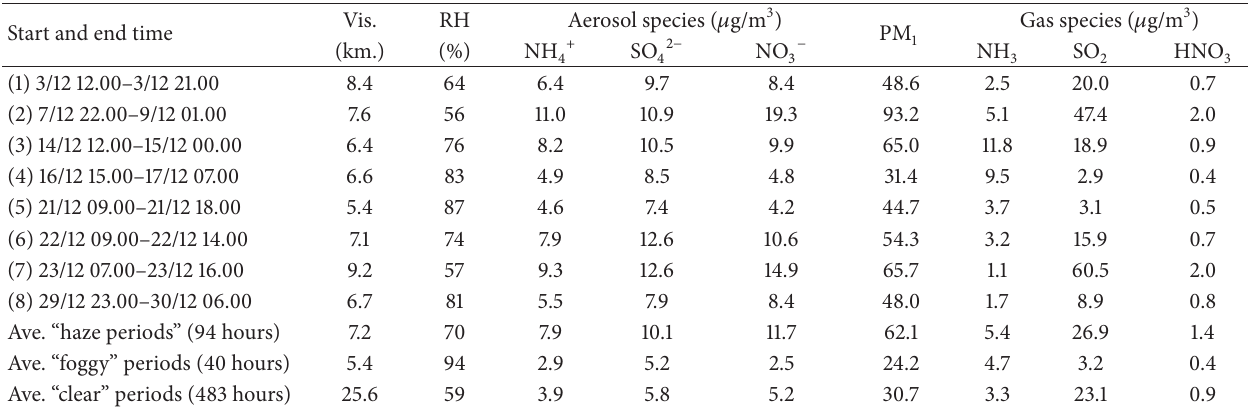
Table 2: Start and end time, visibility, RH, and average concentrations of aerosol and gas species during the haze, foggy, and clear weather